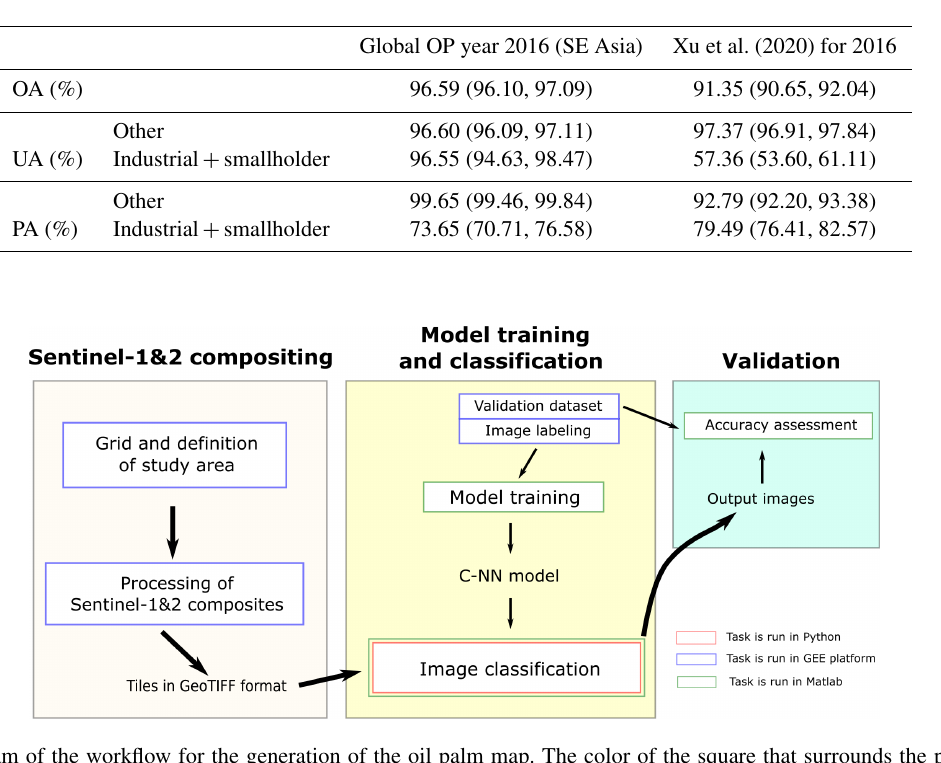
Table A4. Comparison of the classification image obtained with the convolutional neural network (CNN) and the classification image presented in Xu et al. (2020) for 2016. In order to compare both methodologies, we applied the CNN to Sentinel-1 and Sentinel-2 composites of the second half of 2016, which corresponds to the last year of the multi-annual analysis in the dataset of Xu et al. (2020). We used 5199 points randomly distributed in the study area, which covers Malaysia, Sumatra, and Borneo. The accuracy metrics are reported with a confidence interval (95% confidence level).